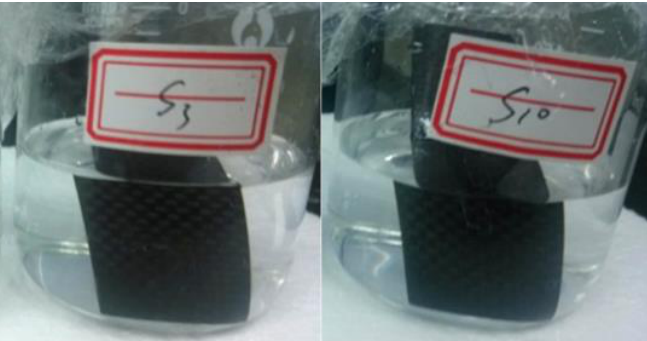
Figure 4. CFRP immersed in 3% (indicated by S3 in the image) and 10% (indicated by S10 in the image) NaCl solution for 21 days without applying current.